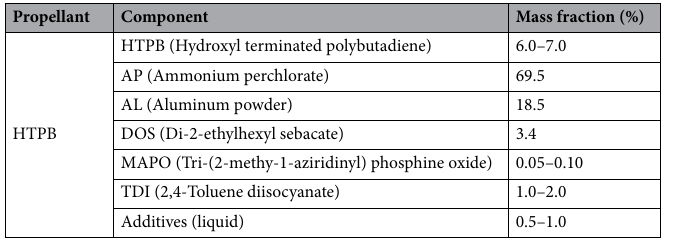
Table 1. HTPB propellant